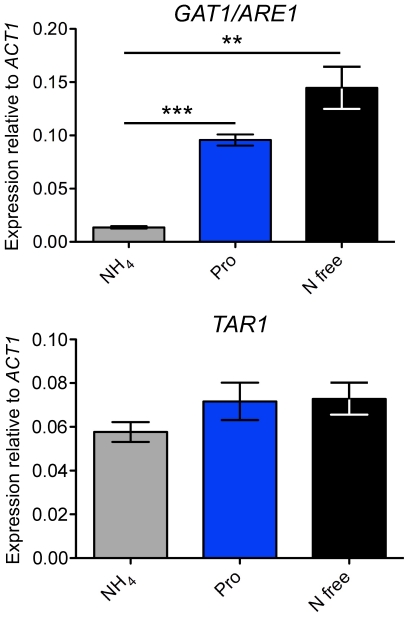
The expression of GAT1/ARE1, but not TAR1, is regulated in response to nitrogen availability.cDNA from wild-type H99 grown in YNB supplemented with ammonium, proline (10 mM each nitrogen source) or no nitrogen source were amplified via qRT-PCR using primers against GAT1/ARE1, TAR1 and the control gene ACT1. In the presence of a preferred nitrogen source (ammonium), the expression of GAT1/ARE1 was low but in the presence of a traditionally non-preferred nitrogen source (proline), or under nitrogen starvation conditions, GAT1/ARE1 transcription was significantly upregulated (** denotes P<0.01, *** denotes P<0.001). In contrast, TAR1 expression was relatively unaltered under these different nitrogen growth conditions. Error bars represent standard errors across three biological replicates.